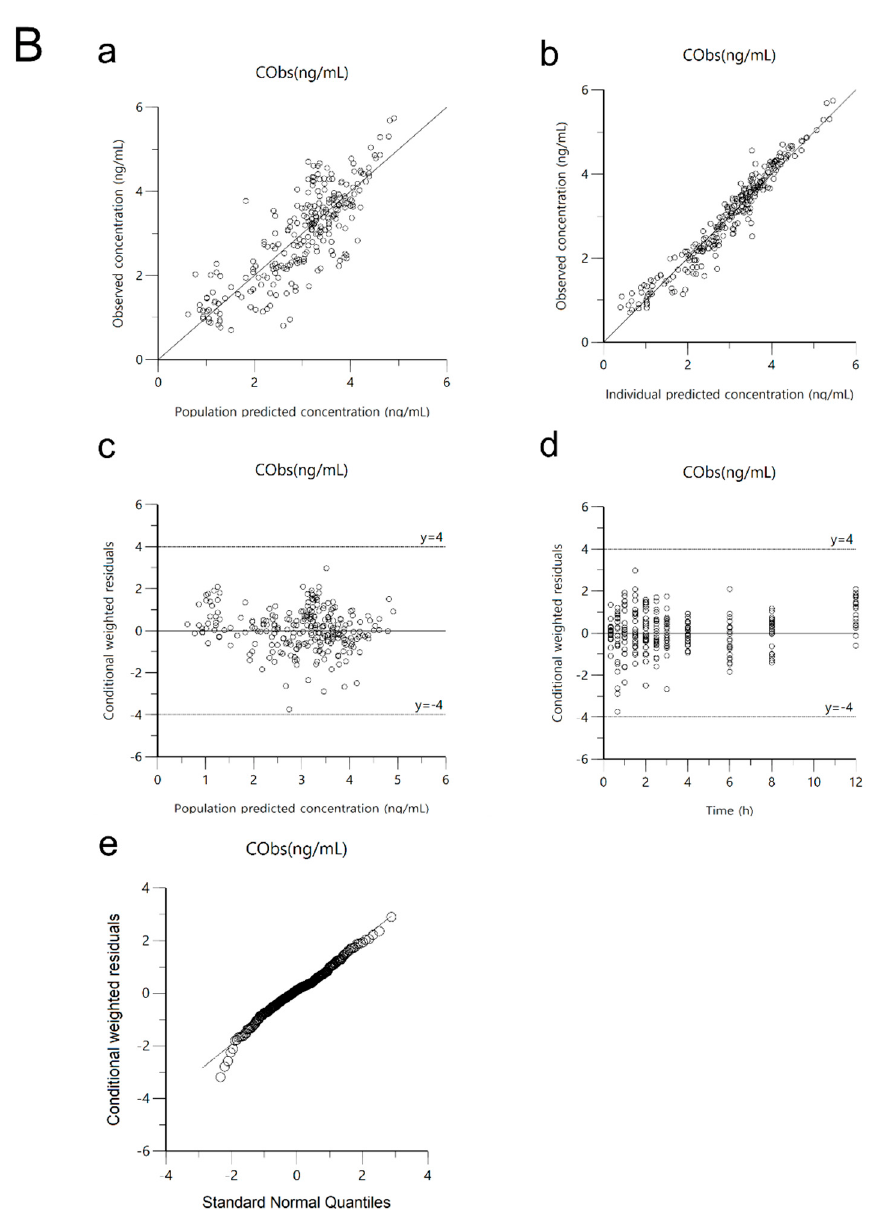
Figure 4. Goodness-of-fit (GOF) plots of base model ( A ) and final model ( B ) for tiropramide. ( a ) Population-predicted concentrations (PRED) against observed plasma concentration (DV), ( b ) individual-predicted concentrations (IPRED) against DV, ( c ) PRED against conditional weighted residuals (CWRES), ( d ) time (IVAR) against CWRES, and ( e ) quantile–quantile plot of components of CWRES.